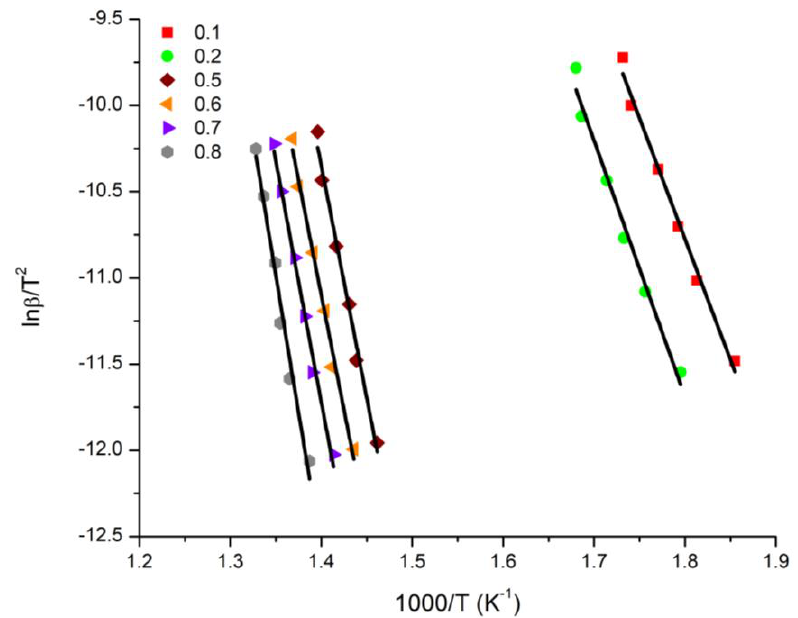
Figure 9. KAS plots for the sample P(NVP – stat – CEVE) 20/80. Table 6. Activation energies, E a (KJ/mol), by the OFW and KAS methods for the P(NVP – stat – CEVE).